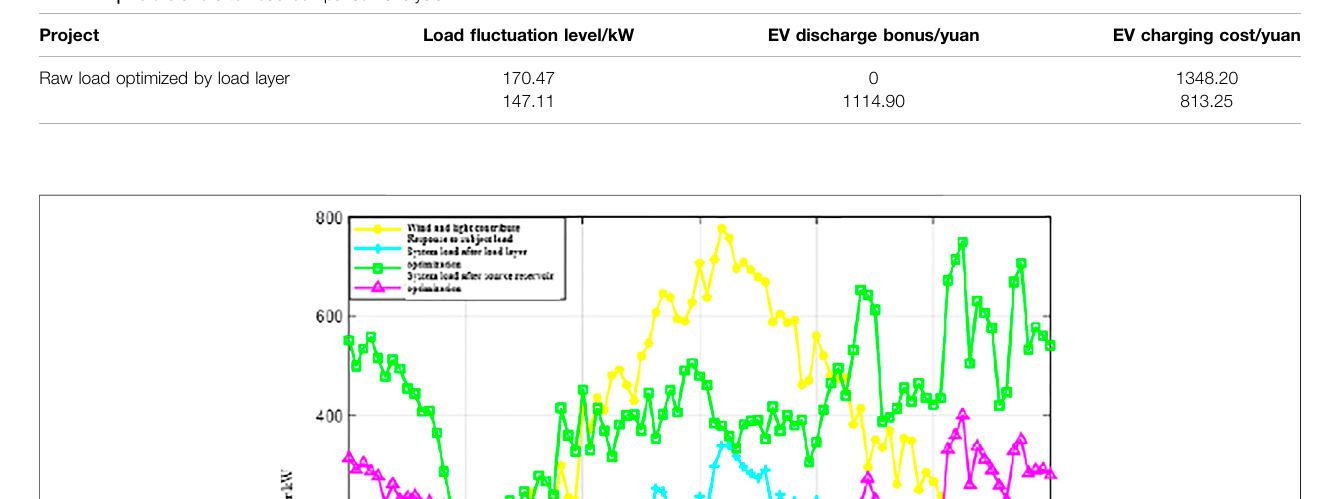
TABLE 1 | Before and after load comparison analysis.